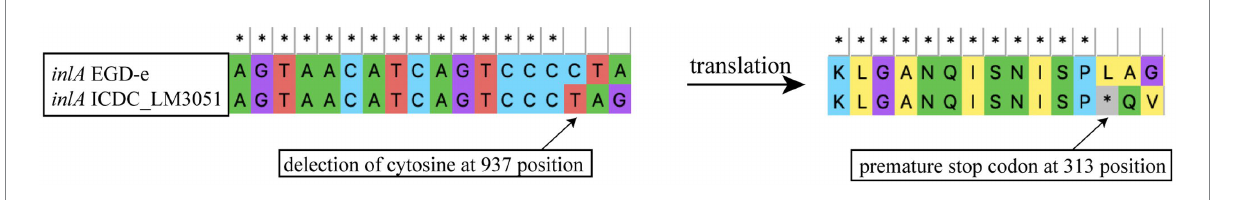
FIGURE 4 Newly identified inlA PMSC mutation type in L. monocytogenes as compared to full-length inlA gene from strain